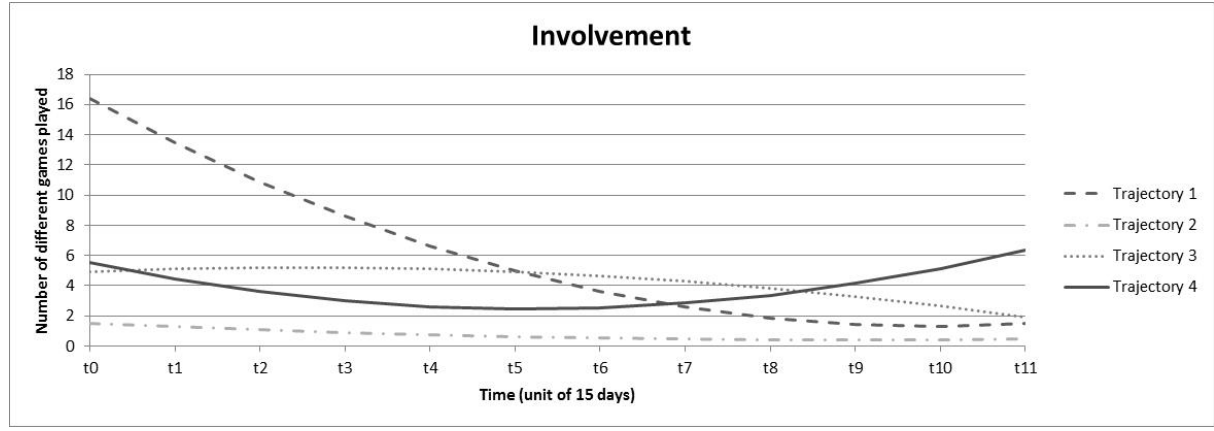
Figure 3. Trajectories obtained from growth mixture models for